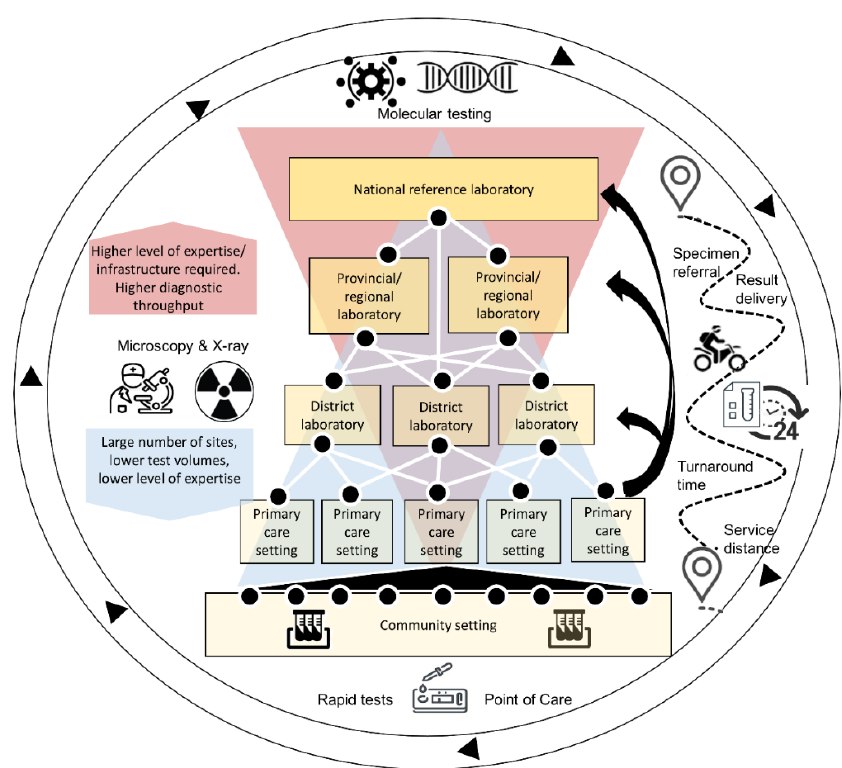
Figure 1. Example of a national, interconnected diagnostic network: At the higher levels of the network there are fewer sites, higher required levels of expertise, and high-throughput diagnostics such as polymerase chain reaction tests for viral detection. At the most basic levels of the network (e.g., clinic and community settings), this includes a large number of sites and rapid diagnostic tests and point-of-care; all functions are supported by a specimen referral system that ensures timely specimen referral and result delivery for all sites, regardless of service distance.